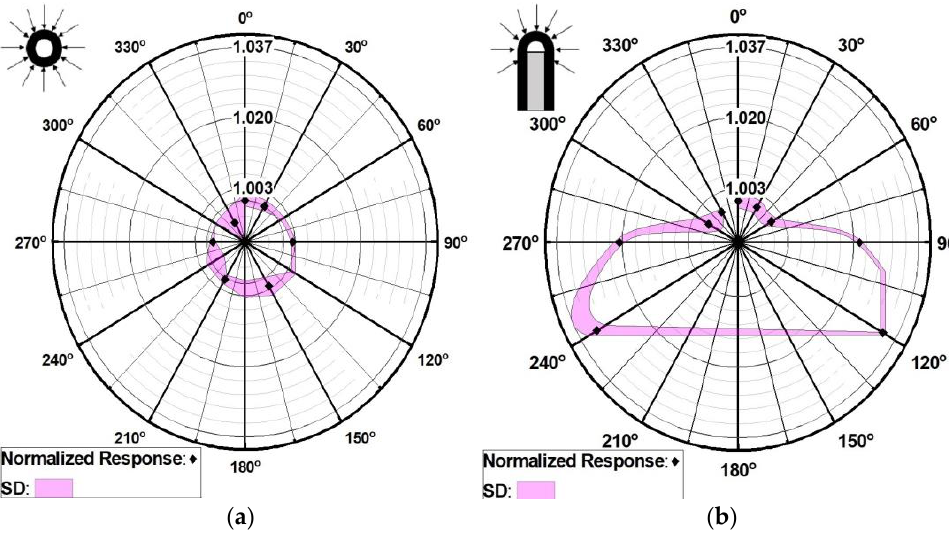
Figure 4. Angular response of DWS 1 scintillator detector. ( a ) longitudinal response, ( b ) polar response. Response is normalized against the signal measured at SARRP 0° gantry angle. SD correspond to the standard deviation of three readings at each gantry angle.